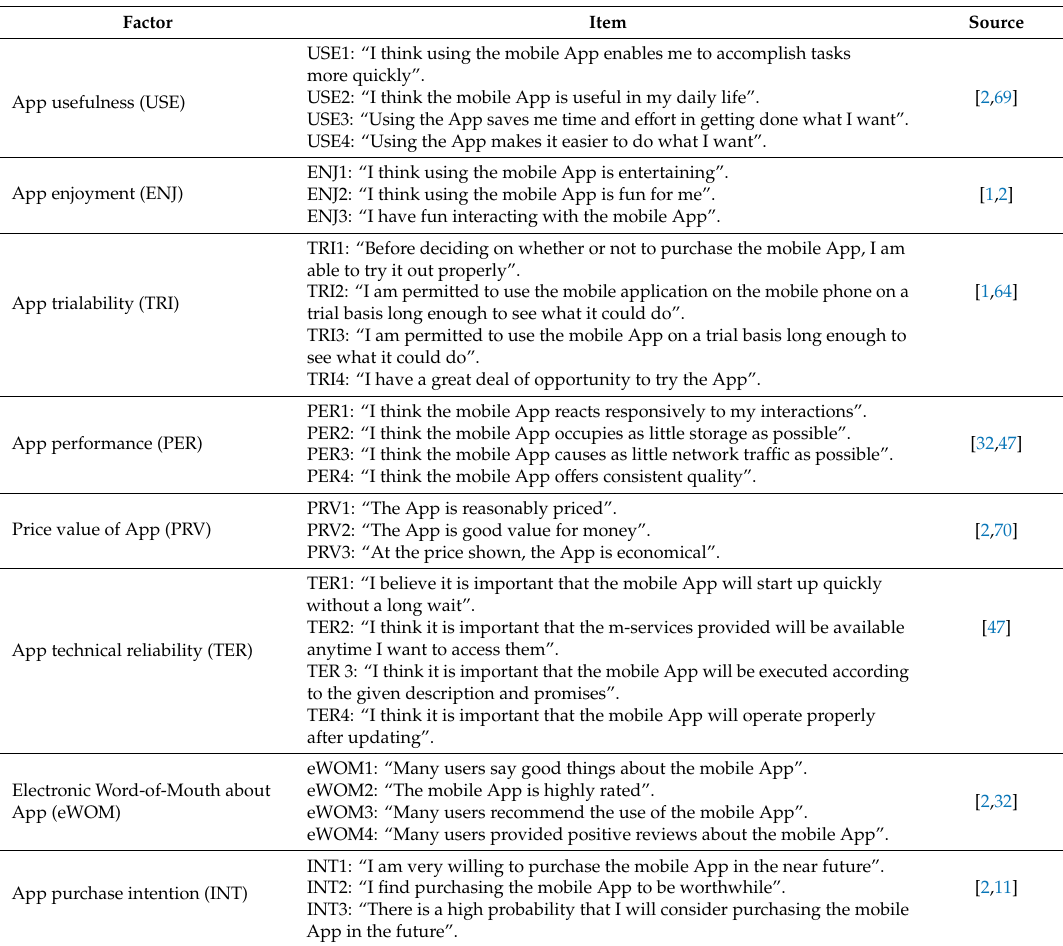
Table 4. Measurement